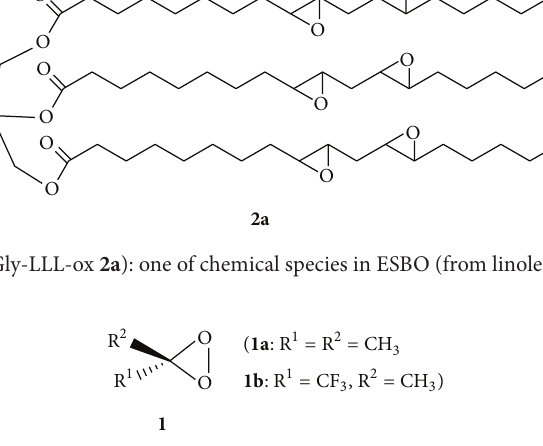
Figure 2: Dioxiranes commonly employed in the isolated form (in solution of the parent